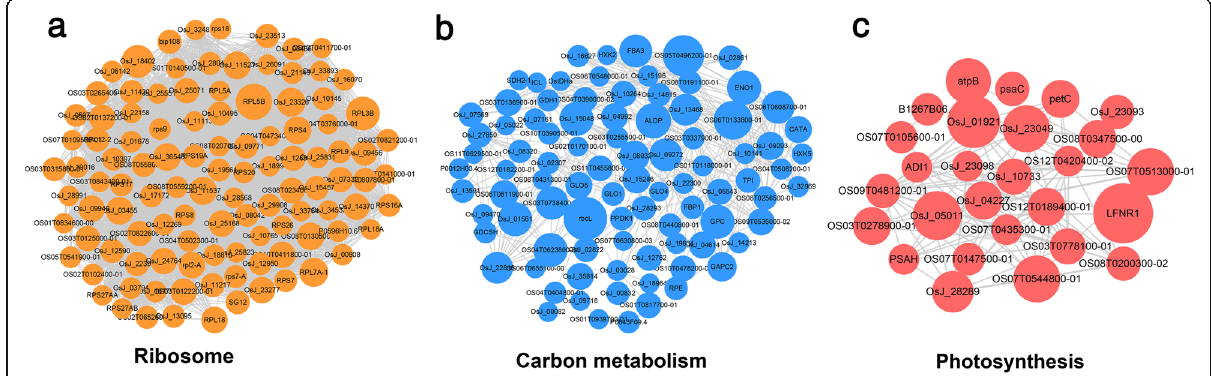
Fig. 7 The three most enriched clusters in the PPI networks of Khib proteins. The network of Khib protein interactions (listed with protein ID names) as analyzed using Cytoscape. a Ribosome. b Carbon metabolism. c Photosynthesis. The size of the dots represents the number of Khib sites in each